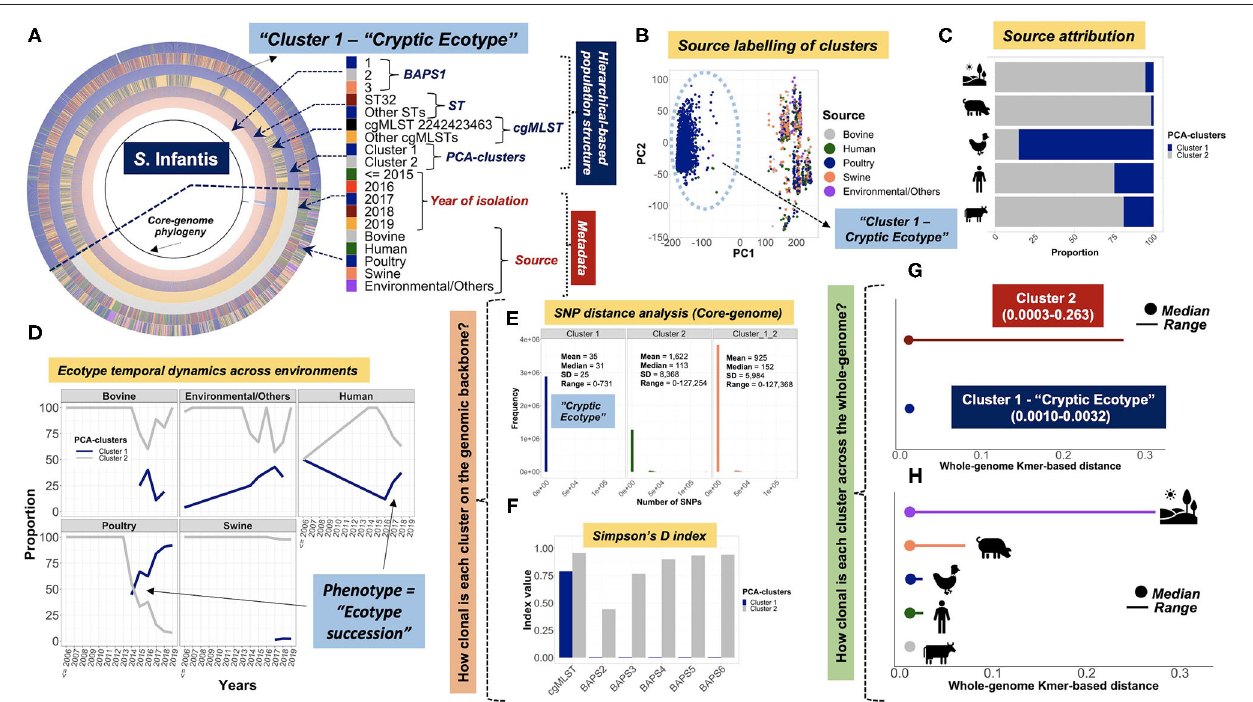
FIGURE 7 | Agnostic mining of S . Infantis pan-genomic data revealed a unique poultry-associated temporal dynamic of putative Ecotypes with potential zoonotic implications. (A) Core-genome phylogeny-guided (black circle) mapping of hierarchical population structure and metadata for S . Infantis ( n = 2,851 genomes). Sequentially mapped onto the tree is the hierarchical-based genotypic classifications: BAPS1 (1st colored ring), ST (2nd colored ring), cgMLST (3rd colored ring), and PCA-clusters (4th colored ring) based on the accessory genome (“shell-loci”) data only; in addition to the metadata comprised of: year of isolation (5th colored ring), and potential source (6th colored ring) based on the NCBI freely available metadata. (B) Accessory genome (“shell-loci”) based clustering of S . Infantis data using a logistic PCA analysis, coupled with a supervised labeling of data points based on source information ( n = 2,851 genomes). (C) Proportion of PCA clusters (i.e., Ecotypes 1 and 2) across sample source which includes from the top-down (y-axis): environmental/others ( n = 139 genomes), swine ( n = 352 genomes), poultry ( n = 1,842 genomes), humans ( n = 433 genomes), and bovine ( n = 85 genomes). (D) Proportion-based temporal dynamics of Ecotypes across sources over time. Proportions were calculated by source per year. Years prior or equal to 2006 were aggregated due to small total number of genomes ( n = 47 genomes). The predicted phenotype, namely “Ecotype succession,” can be referred as a population-based phenotypic-switching that is primarily observed in poultry. (E) Pairwise SNP-based core-genome distances between genomes calculated using snp-dists. Distances are plotted to examine the distribution of SNPs within and between clusters (i.e., cluster 1 = Ecotype 1). Cryptic ecotype 1, which appears to be poultry-restricted, has a higher degree of clonality due to having a narrower distribution of pairwise SNPs as compared to cluster 2 (e.g., smaller mean and standard deviation). (F) Simpson’s D index of diversity, calculated using cgMLST ( n = 2,802 genomes) and BAPS2-6 ( n = 2,851 genomes per BAPS level) haplotype data, also showed that Ecotype 1 has a higher degree of clonality than Ecotype 2 (i.e., the higher the index value, the more genotypic diverse a population is). Within cluster (G) or across sources (H) , pairwise whole-genome k-mer based distances calculated using Mash ( n = 2,851 genomes). (G) The number of genomes used per cluster was: cluster 1 ( n = 1,699 genomes), and cluster 2 ( n = 1,152 genomes). For plot (H) , icons represent the following sources for genomes (top-down across y-axis): environment/others ( n = 139 genomes), swine ( n = 352 genomes), poultry ( n = 1,842 genomes), humans ( n = 433 genomes), and bovine ( n = 85 genomes). For both plots (G) and (H) , the dot and bar represent the median and range values, respectively; and the smaller the range, the more clonal the cluster, or Ecotype, is at the whole-genome level. Core-genome phylogeny was visualized using